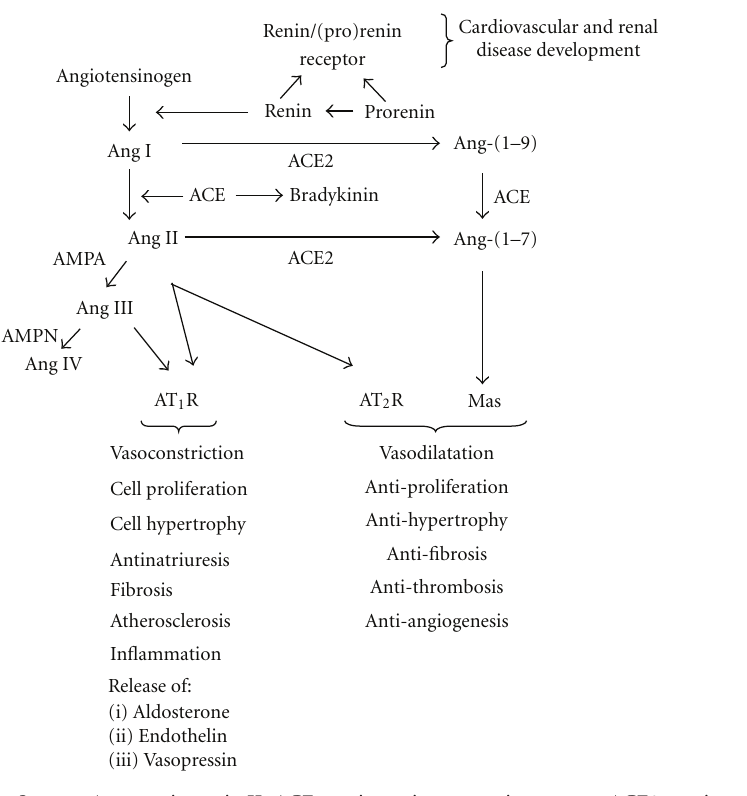
Figure 2: The Renin-Angiotensin System. Ang: angiotensin II. ACE: angiotensin-convertin enzyme, ACE2: angiotensin-converting enzyme 2, AMPA: aminopeptidase A. Please see text for